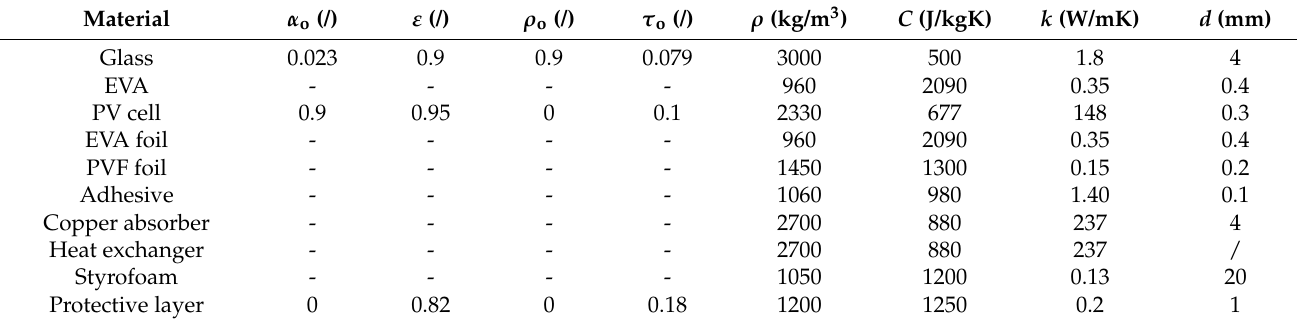
Table 2. Thermal, mechanical, and optical parameters of the considered mono-crystalline PV/T collector.